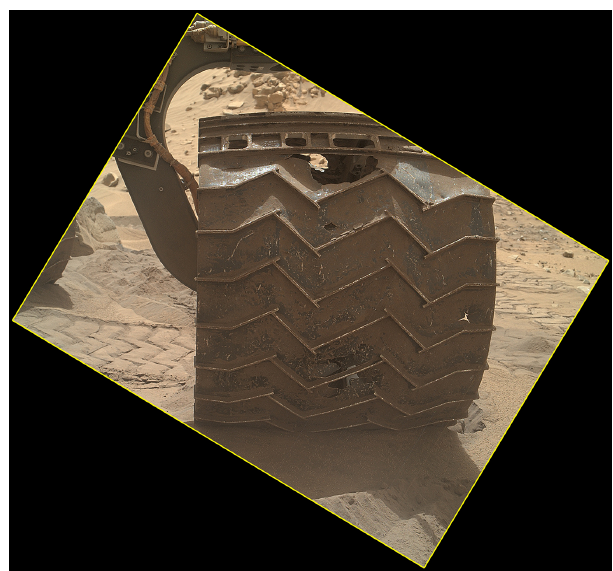
Figure 6. Example of rover wheel inspection imaging, acquired on sol 713 (8 August 2014). Curiosity’s wheels are 40cm wide. Be- cause the wheels are a non-renewable resource, MAHLI is used on a regular basis to monitor damage; thus, single MAHLI wheel imaging (SMWI) is acquired after every ∼ 100m of driving and full MAHLI wheel imaging (FMWI) is acquired every ∼ 500m. MAHLI images also contribute to the science team’s efforts to iden- tify and avoid driving across terrain that is potentially hazardous to the wheels (Yingst et al., 2014). Illuminated by sunlight from the upper left, this is MAHLI image 0713MH0002620000204354E01. in which a = 0.576786, b = − 11.8479, c = 2.80153 × 10 − 3 , d = − 2.266488 × 10 − 7 , and e = 6.26666 × 10 − 12 .